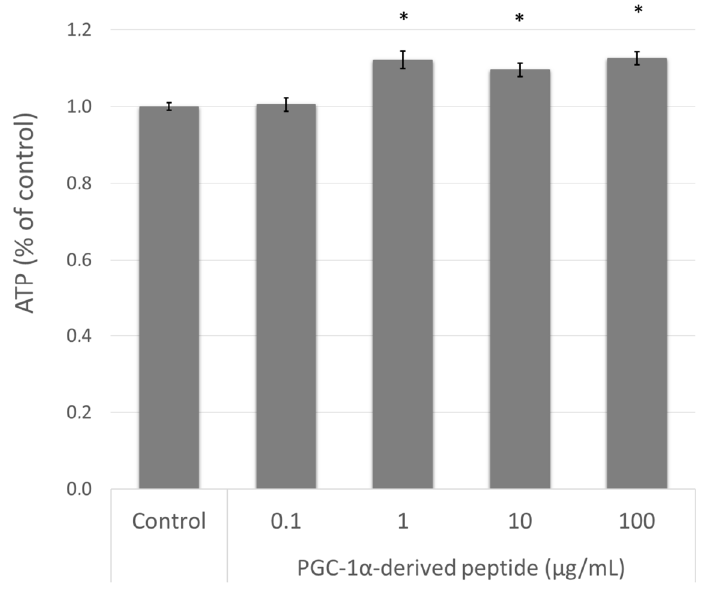
Figure 4. The ATP (adenosine triphosphate) level in NHDF cells. NHDF cells were treated with the PGC-1 α -derived peptide at various concentrations for 24 h, then the ATP was measured. The values represent means ± SEM of at least 3 independent experiments (* p < 0.05 compared with untreated control group).